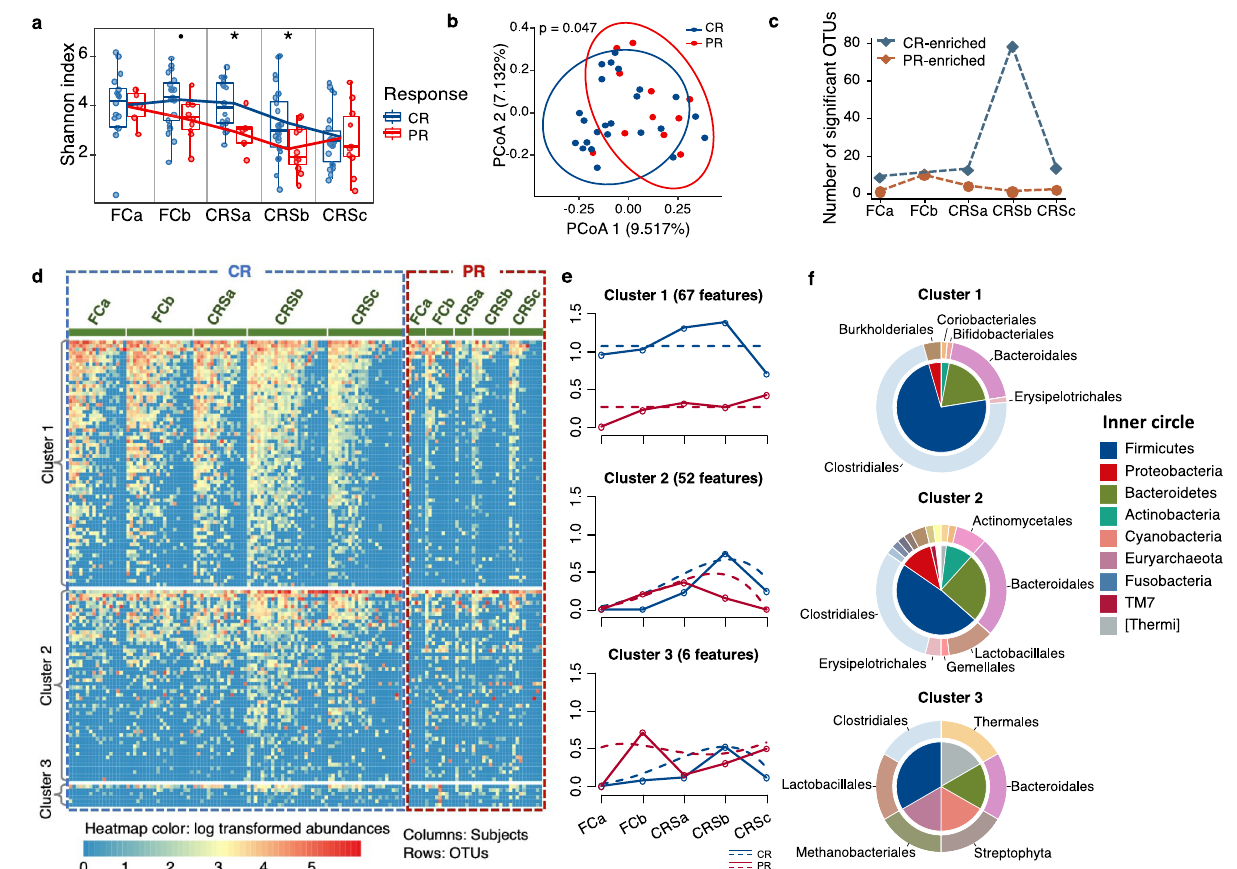
Fig. 3 | Association of compositional differences in gut microbiome with responses to CAR-T therapy in MM patients. a Shannon diversity indices of gut microbiomedifferedbetweenCRandPRgroupsacrossCAR-Tstages.Signi fi cances were assessed by two-sided Wilcoxon rank-sum test ( n =35). P values were 0.077, 0.040, 0.036 for FCb, CRSa, and CRSb, respectively. Boxplots indicate the median (thick bar), fi rst and third quartiles (lower and upper bounds of the box, respec- tively),lowestandhighestdatavaluewithin1.5timestheinterquartilerange(lower and upper bounds of the whisker). b Principal coordinate analysisof fecal samples in CRSb stage by response (CR versus PR) using Canberra distance. P value was calculated by PERMANOVA ( n =35). c Summary of number of PR or CR-enriched OTUs in different therapy stages. Difference between CR and PR groups was assessed by two-sided Wilcoxon rank-sum test. P value signi fi cant cutoff was 0.05